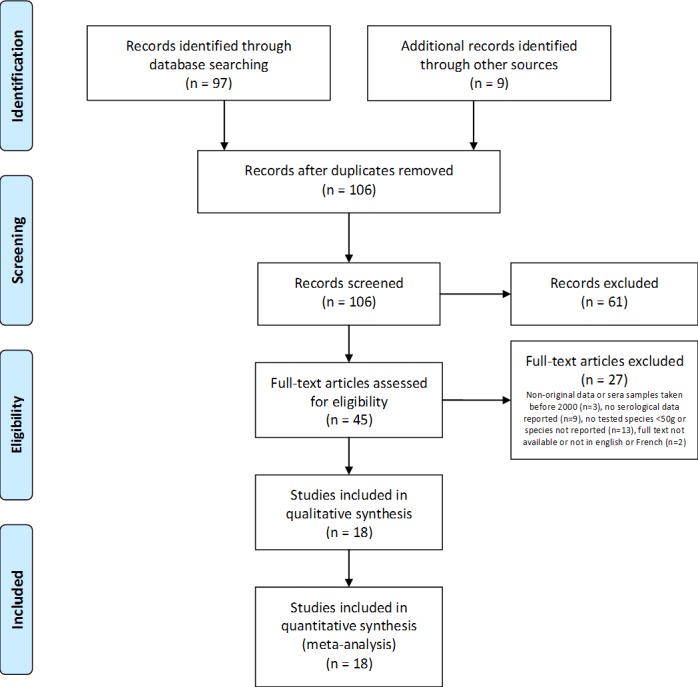
PRISMA flow diagram for included paper selection (adapted from [28]).